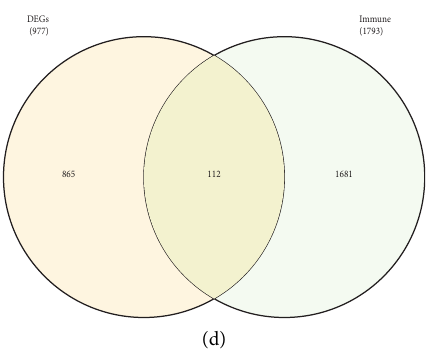
Figure 2: (a) Te diferential expressed analysis between Immunity_L and Immunity_H subtype; (b) the heat map demonstrated the gene expression level between Immunity_L and Immunity_H subtype; (c) the GO and KEGG enrichment analysis based on the diferential expressed genes; (d) the Venn diagram demonstrates the genes involved in immune-related genes and diferential expressed